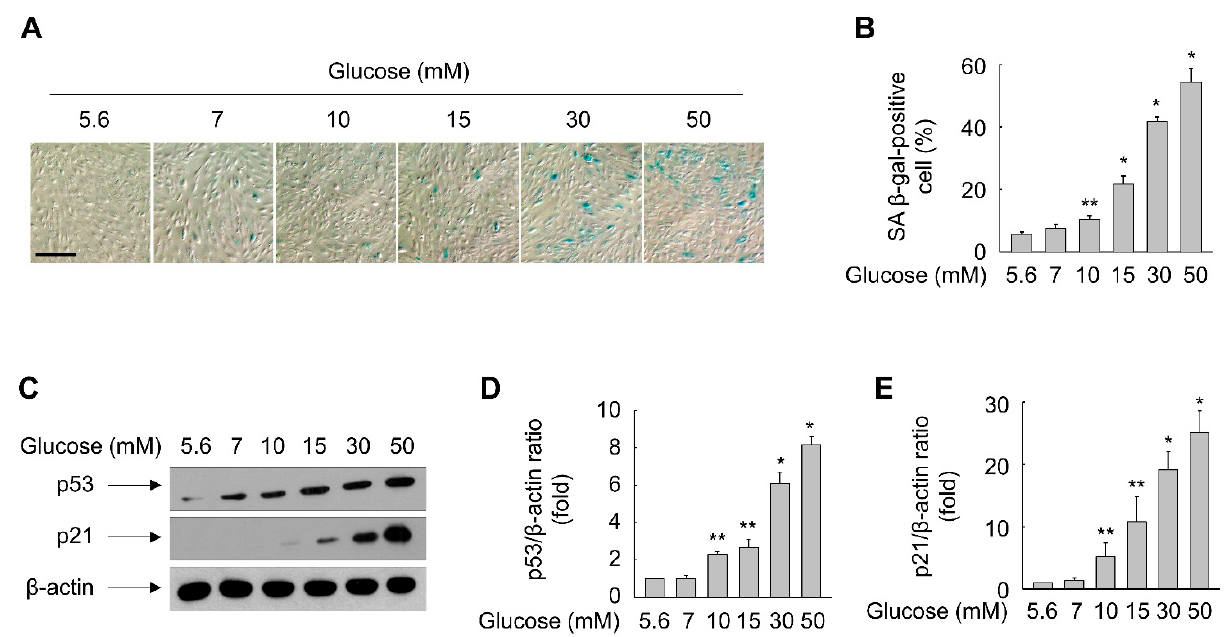
Figure 1. Glucose triggers senescence of ARPE-19 cells. ( A – E ) Cells grown in 60 mm dishes were exposed to increasing concentrations of glucose. Following incubation for 48 h, SA β -gal staining was performed ( A ) and SA β -gal-positive cells were quantified ( B ). The scale bar indicates 100 µ m. Whole-cell lysates were subjected to immunoblot analyses ( C ) and the band intensities were quantified ( D , E ). Representative images from three independent experiments are shown. Quantitative data are presented as means ± S.E. ( n = 3 for Western blotting and n = 6 for SA β -gal staining). * p < 0.01, ** p < 0.05 compared with the 5.6 mM glucose-treated group.